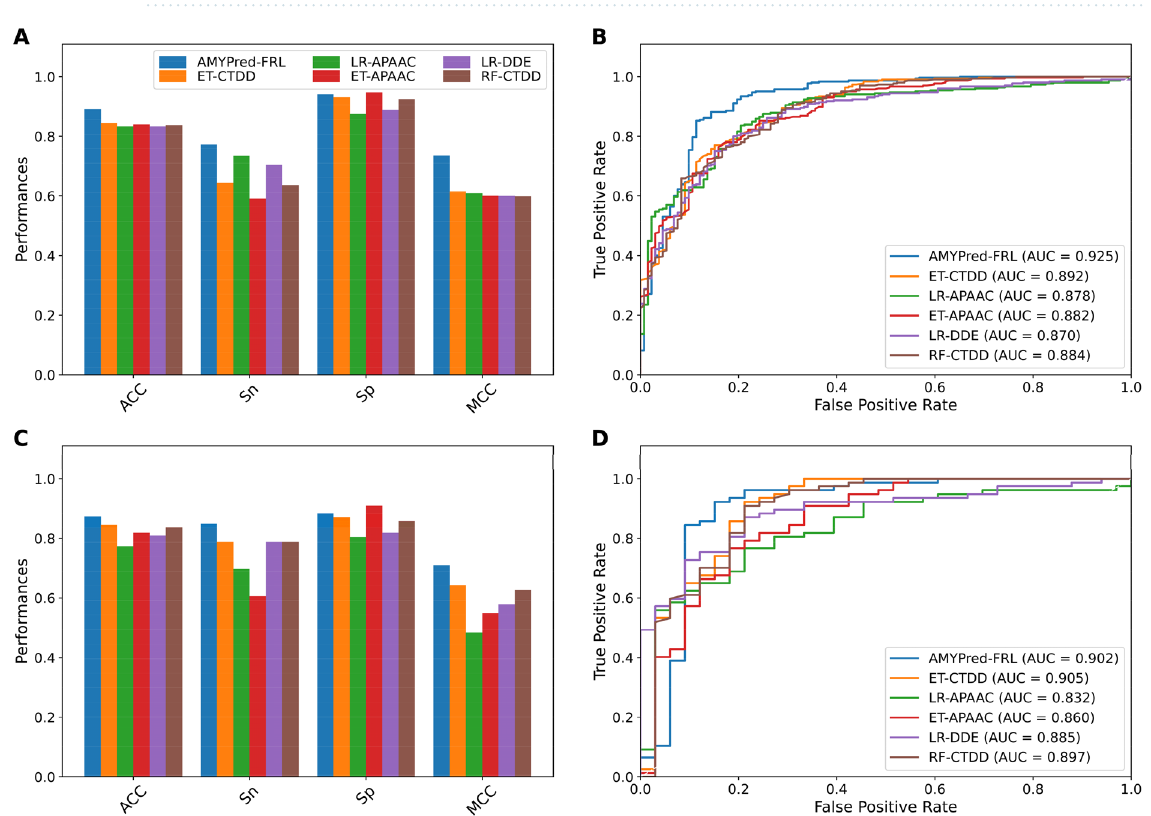
Figure 6. Performance comparison of AMYPred-FRL with the top five baseline models on the training ( A , B ) and independent tests ( C , D ). Prediction results of AMYPred-FRL and the top five baseline models in terms of ACC, Sn, Sp and MCC ( A , C ). ROC curves and AUC values of top five baseline models ( B , D